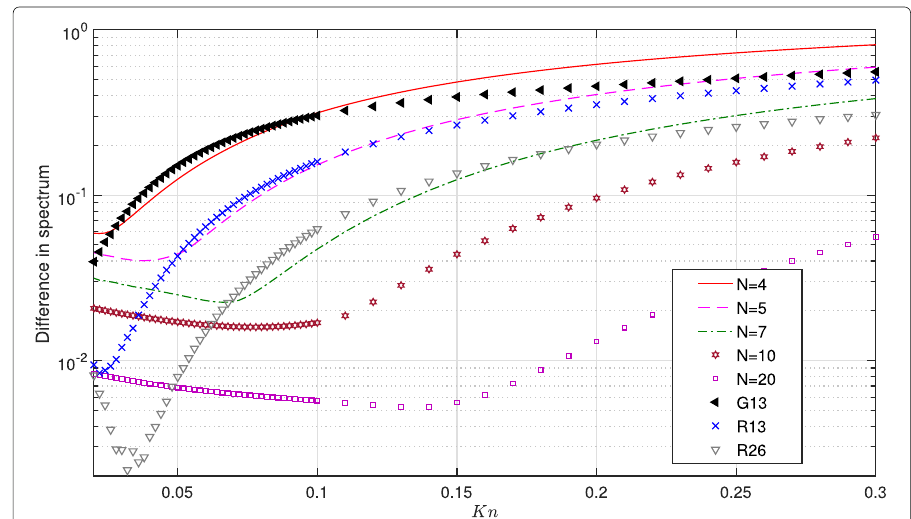
Fig. 10 Difference in the spectrum of spontaneous RBS. Results for G13, R13, and R26 moment equations are (cid:7) ∞ | S N − S N = 60 | df N being the spectrum obtained by obtained from Fig. 9a, while others are s with S ∞ GH GH GH solving the Shakhov kinetic model (44) with the Gauss-Hermite quadrature of order N ; in three-dimensional molecular velocity space v , the number of total discrete velocity points is N 3 , while the corresponding Grad moment equations have ( N + 1 )( N + 2 )( N + 3 )/ 6 moments [19]. Note that before the comparison, areas of RBS spectra are normalized to unity. The solution may be viewed to be accurate when the relative difference is less than 0.05. Also note that the relative difference when N = 5,7,10 and 20 does not decrease with Kn when Kn (cid:4) 0.1 is probably because in spontaneous RBS the spectrum between the Rayleigh and Brillouin